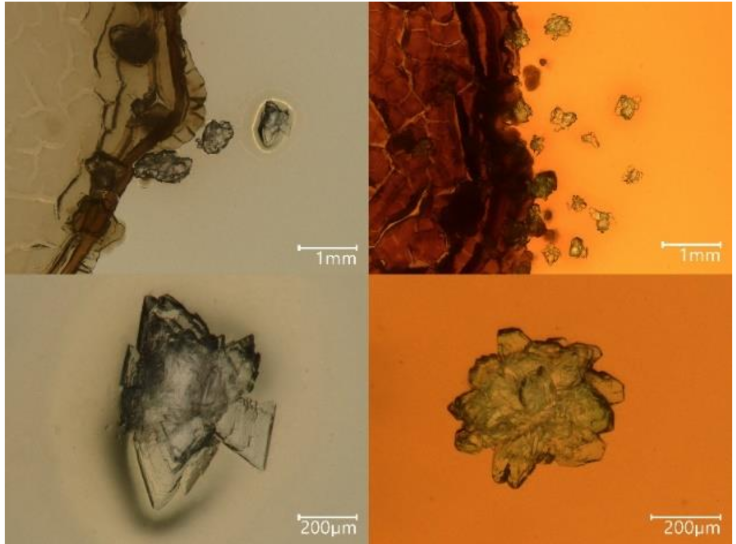
Figure 1. Crystals produced by S. mirabilis grown on solid media. Crystals in media without additional nickel ( left ) were compared to those produced if 10 mM NiSO 4 had been added ( right ).